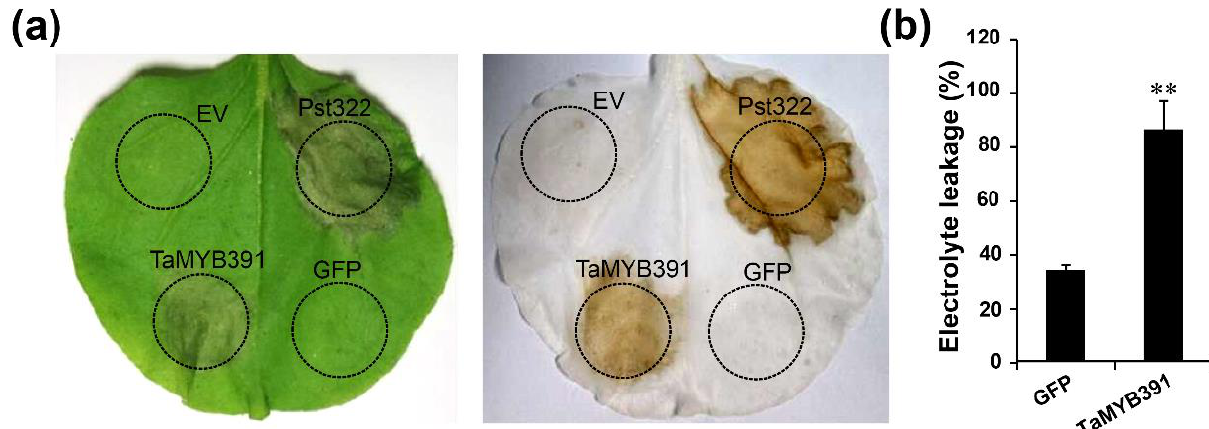
Figure 2. Transient overexpression of TaMYB391 induces programmed cell death in N. benthamiana . ( a ) A. tumefaciens cells carrying TaMYB391 , Pst332 , or an empty vector were infiltrated into N. benthamiana leaves within the regions indicated by dashed lines. The cell death phenotype was photographed seven days after agroinfiltration. The right panel shows the same leaf as on the left panel after decolorization with ethanol. ( b ) Quantification of cell death by measuring electrolyte leakage four days post-agroinfiltration (dpa). Means and SEs were computed from three independent experiments. The statistical analyses were performed with Student’s t -test. Bars indicate ± SE. **, p < 0.01.